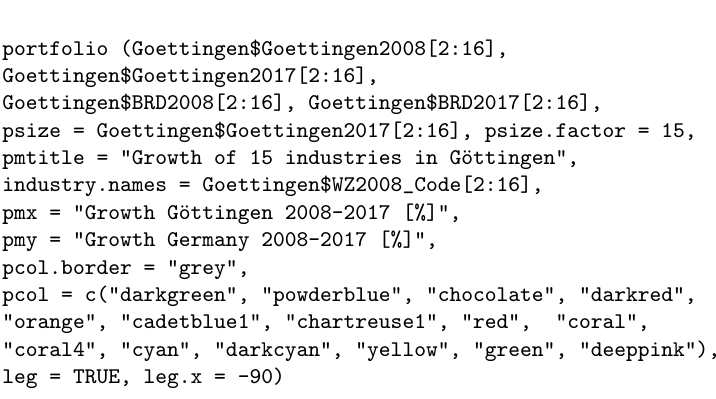
Figure 6: Portfolio matrix analysis for 15 industries in